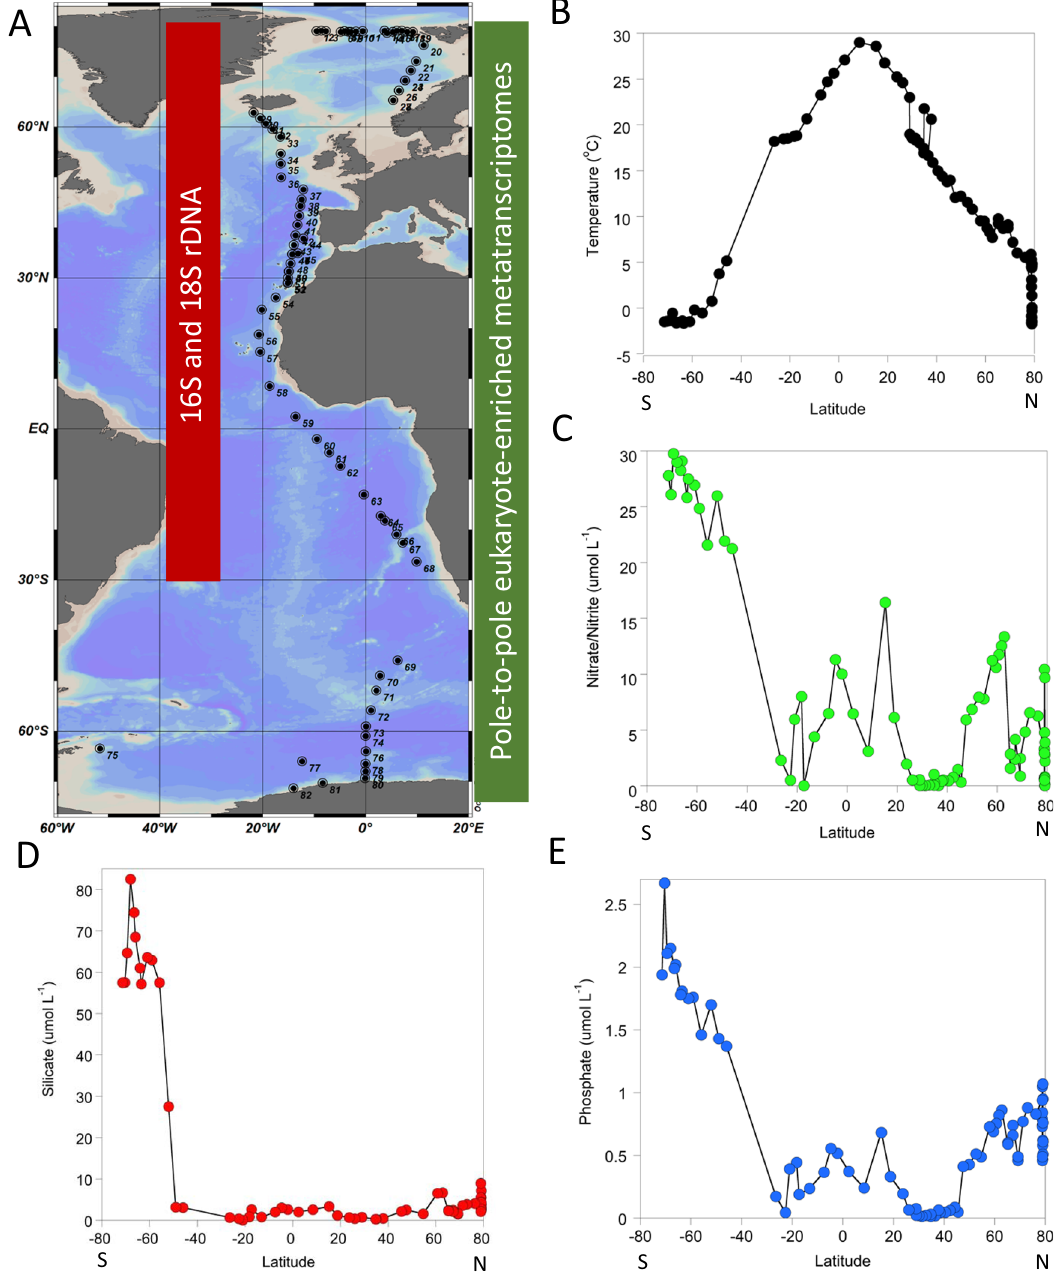
Fig. 1 Sampling sites and environmental metadata. A Stations for metatranscriptome sequencing (green) and 16 and 18S rDNA amplicon sequencing (red). Map was generated using Ocean Data view. B Latitude versus temperature (degree celsius). C Latitude versus nitrate and nitrite concentrations. D Latitude versus silicate concentrations. E Latitude versus phosphate concentrations. Nutrient concentrations in µ mol L − 1